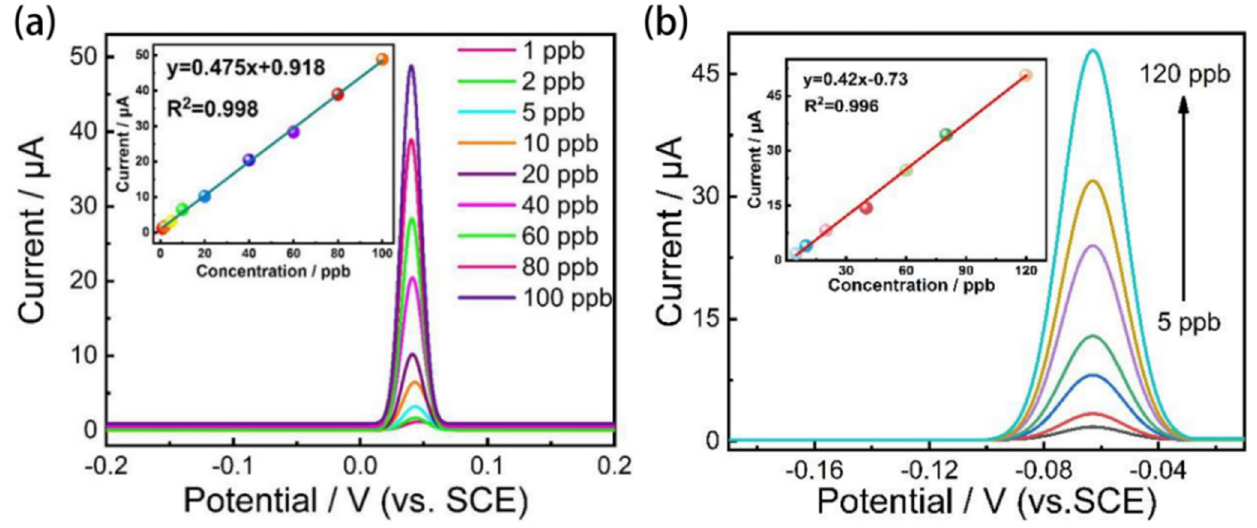
Figure 10. Standard curves and detection limits for G/SBDD and SBDD. ( a ) Dissolution curve of G/SBDD electrodes for Pb 2+ at concentrations ranging from 1 to 100 ppb; inset shows the fitted curve of ion concentration versus dissolution peak intensity; ( b ) Dissolution curves of SBDD electrodes for Pb 2+ at concentrations ranging from 5 to 120 ppb; inset shows the fitted curve of ion concentration versus peak dissolution current value.